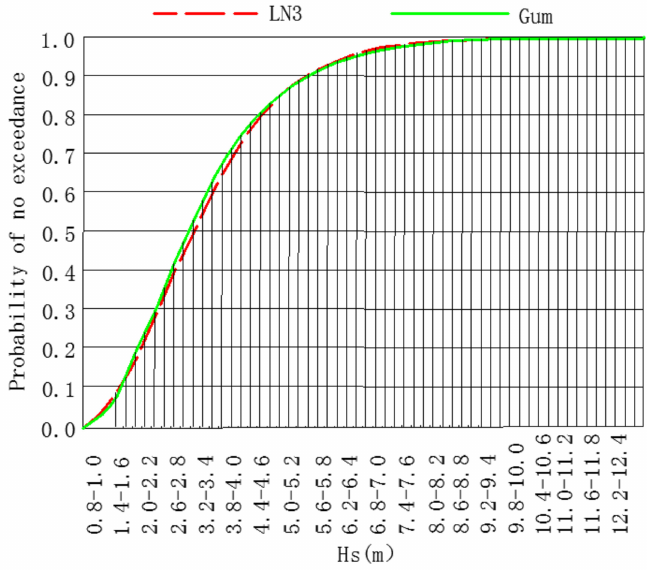
Figure 7. Probability of no exceedance for H s using LN3 and Gum . According to the percentage of wave heights not exceeding threshold h ac in winter, waiting time T w and persistence time T p can be estimated for given h ac , as shown in Table 2. Table 2. Waiting time and persistence (in days) of threshold heights (1.4–3.4